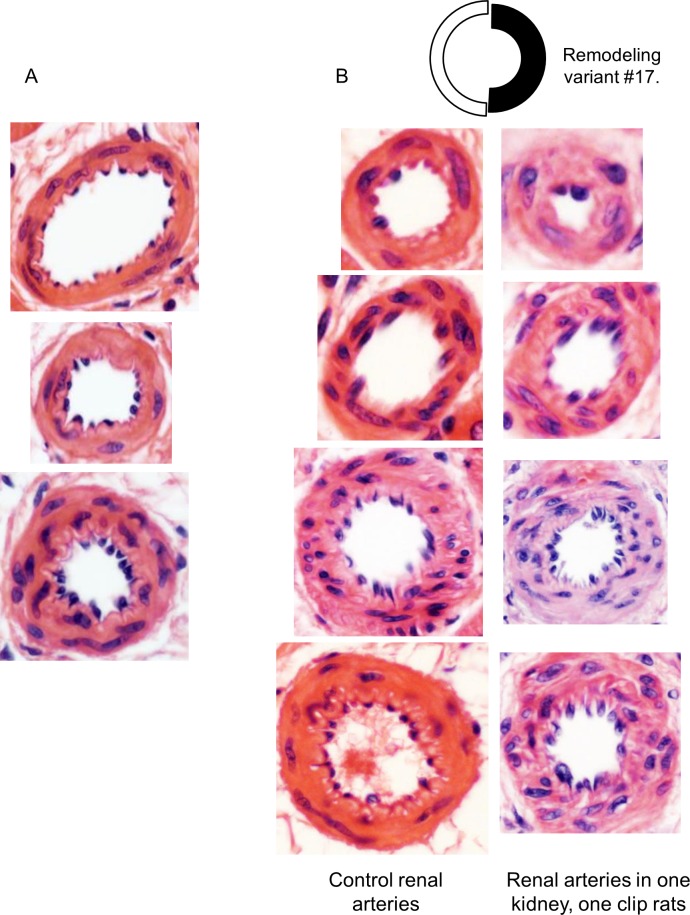
The conundrum in arterial remodeling assessment.(A) Rat arteries in hypertensive rats. Each artery could be an image of another one before or after remodeling: there is no a structure or phenotype marker indicating its previous dimensions. (B) Identification of a remodeling variant enables comparative analysis in arteries of a different range. Hematoxylin-eosin, x400.